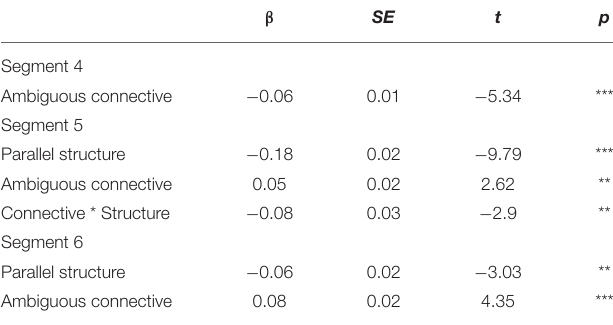
TABLE 9 | Model of the L2 data on segments 4, 5, and 6 (Experiment 3).